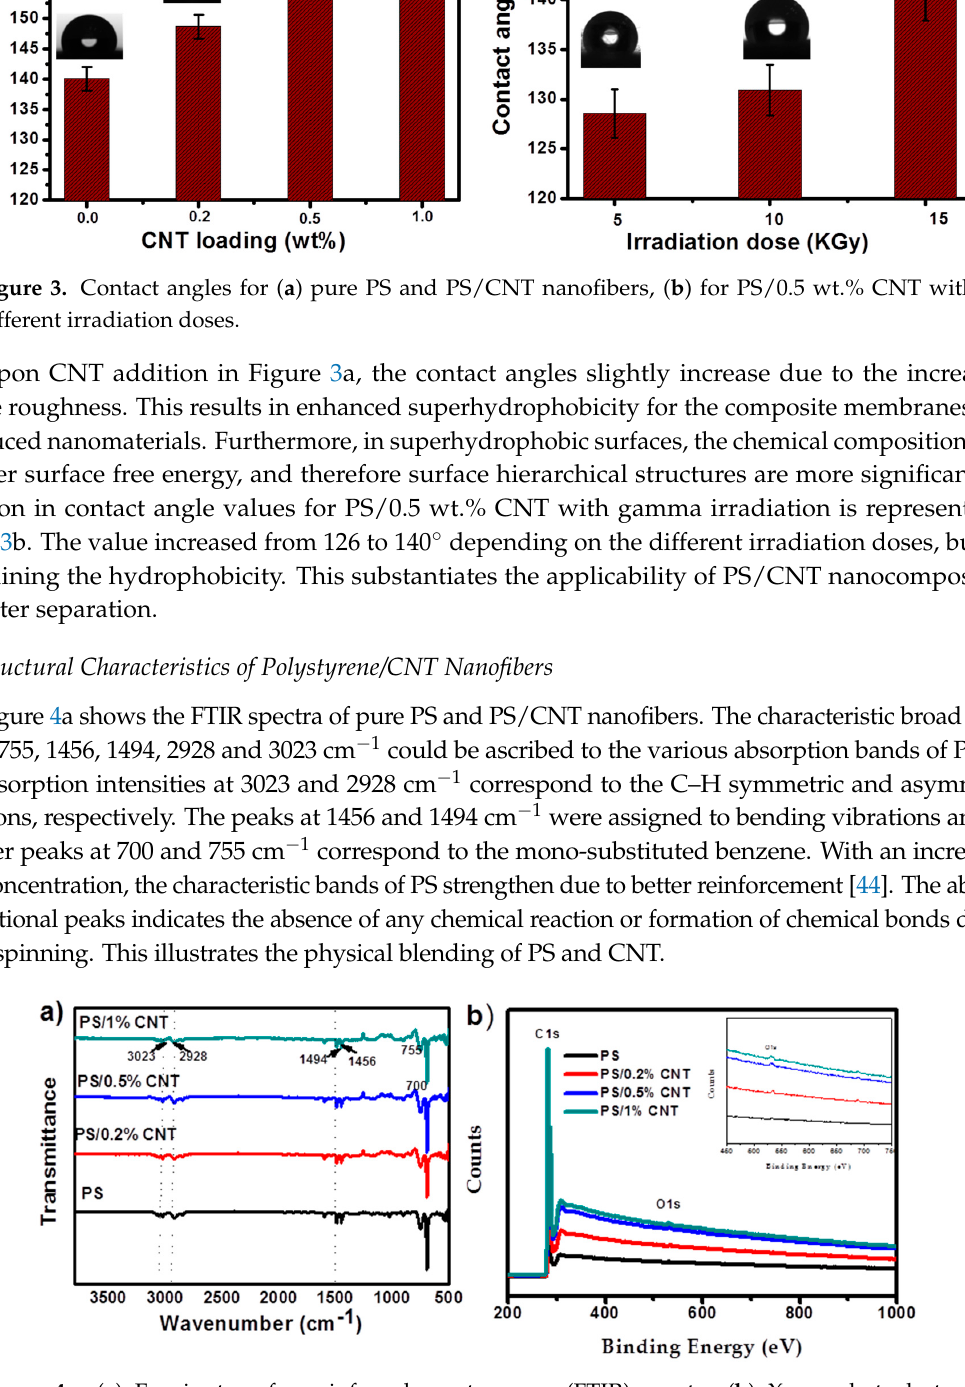
Figure 4. ( a ) Fourier-transform infrared spectroscopy (FTIR) spectra ( b ) X-ray photoelectron spectroscopy (XPS) spectra of pure PS and PS/CNT membrane, the inset shows the lower intense peaks related to oxygen (O1s).